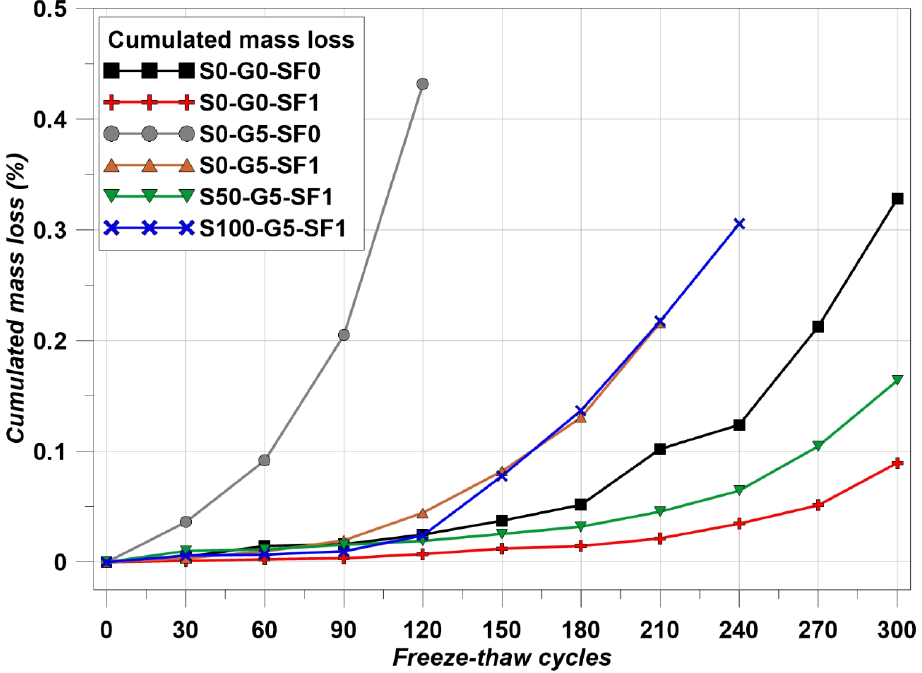
Figure 14. Mass loss results.